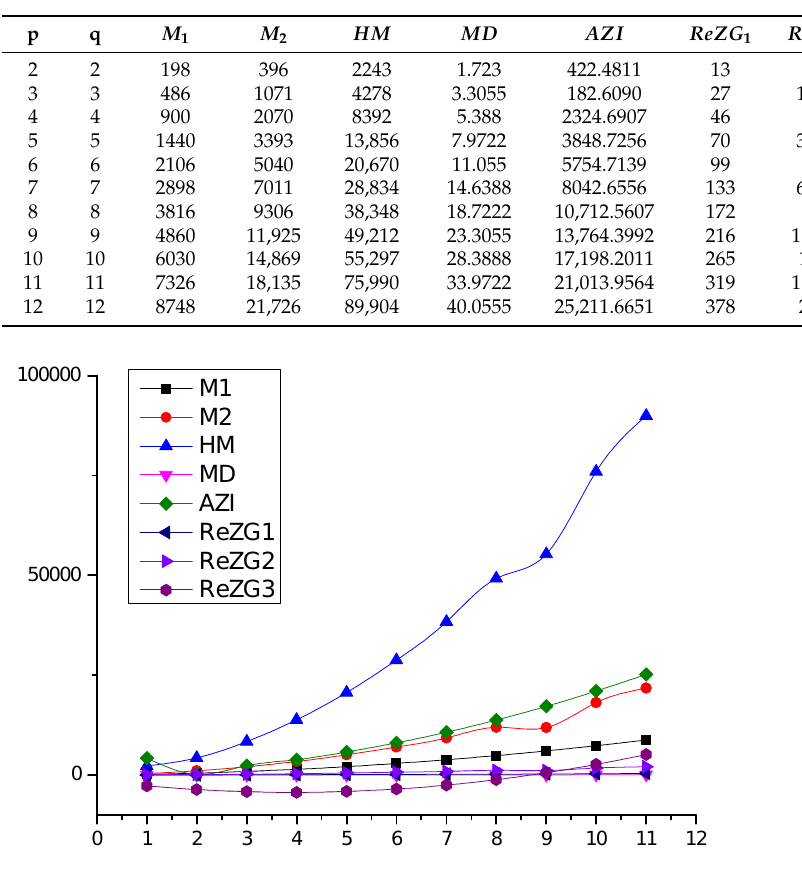
Figure 2. Graphical comparison of Zagreb indices for p , q ≥ 2, p = q .